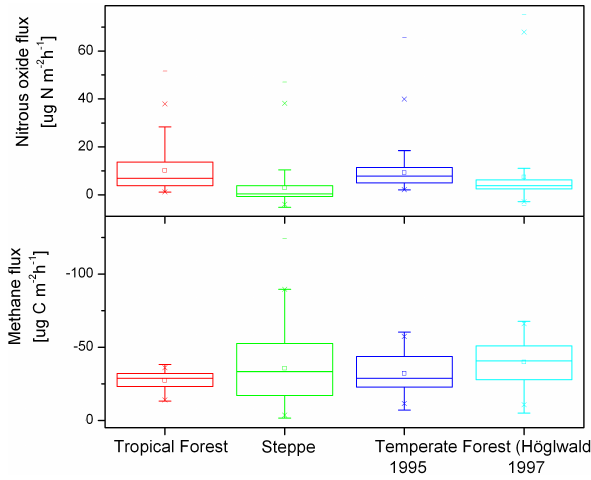
Fig. 5. Box plot of daily average soil nitrous oxide and methane fluxes in tropical forest, semi-arid steppe, and temperate forest (H¨oglwald: data from both years 1995 and 1997). The boxes are determined by 25th and 75th percentiles. The whiskers are deter- mined by the 5th and 95th percentiles. Additional values can be represented in box chart, including the minimum and maximum (dashes), median (line in the box), mean (square), 1st percentile and 99th percentiles